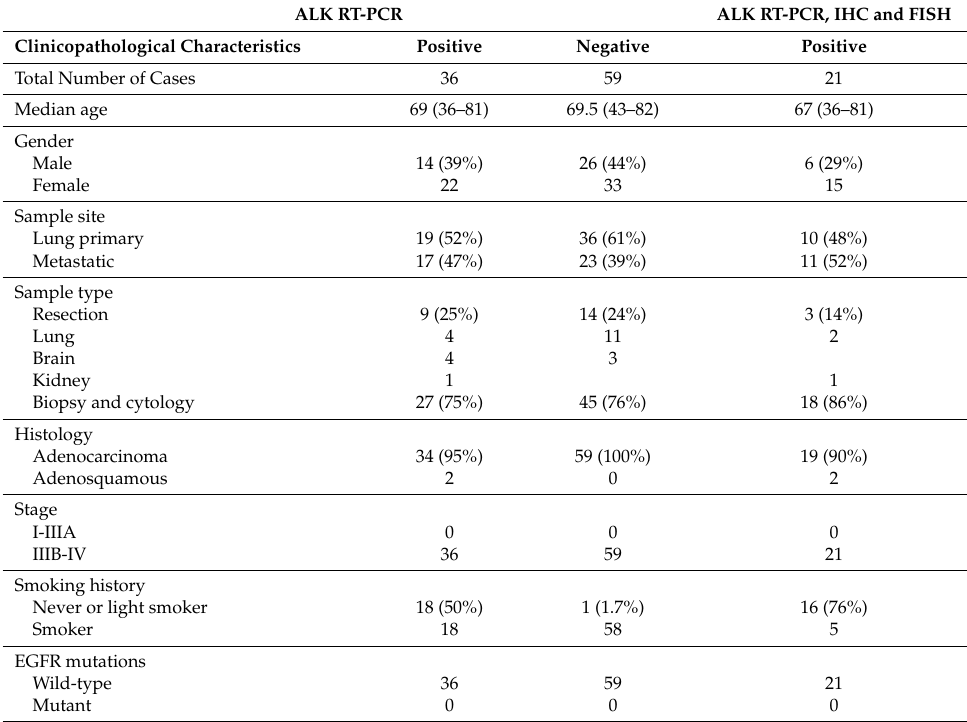
Figure 1. Schematic of full-length ALK and EML4-ALK fusion transcripts indicating location of ALK RT-PCR assay. Regions of the transcript which encode domains in the ALK protein are indicated: Extracellular domain of receptor (Extracellular), transmembrane domain (TM), tyrosine kinase domain (Kinase), echinoderm microtubule associated protein like 4 ( EML4 ) fusion gene partner. Arrows indicate location of RT-PCR primers and green bar indicates fluorescent probe. Table 1. Clinical and pathological characteristics of cases tested by ALK RT-PCR in 95 patients. ALK RT-PCR ALK RT-PCR, IHC and FISH